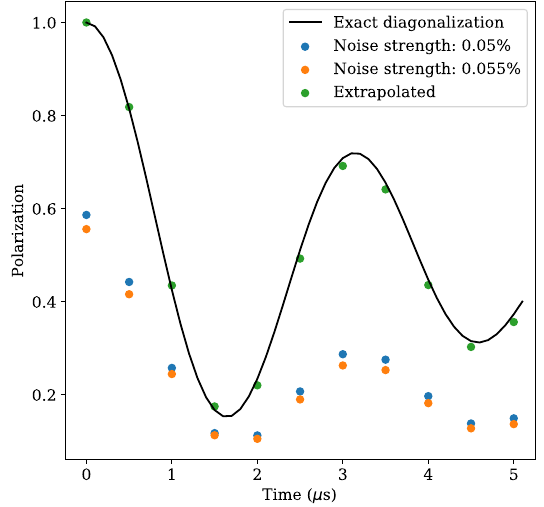
FIG. 13. Using exponential extrapolation of data obtained at two different noise rates to infer the noise-free polarization func- tion. The extrapolation is performed using Eq. (55). The data points are obtained in the same way as described in the caption of Fig. 12. The expected number of errors in the circuit is